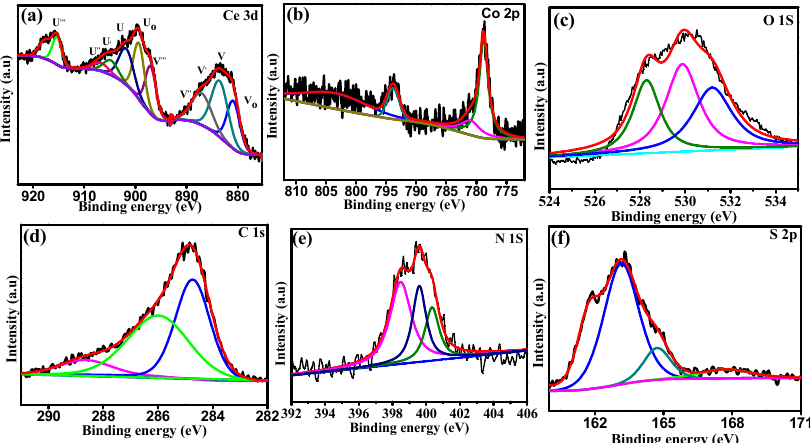
Figure 4. ( a ) Core level spectra of Ce 3d, ( b ) Co 2p, ( c ) O1s, ( d ) C 1s, ( e ) N 1s and ( f ) S 2p for 3% Co–CeO 2 /N, S–rGO.